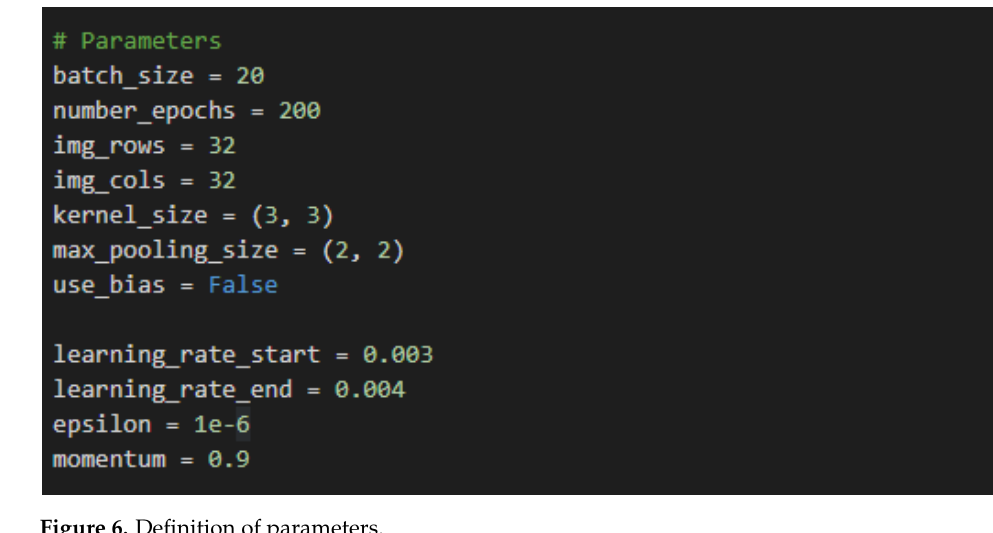
Figure 6. Definition of parameters.